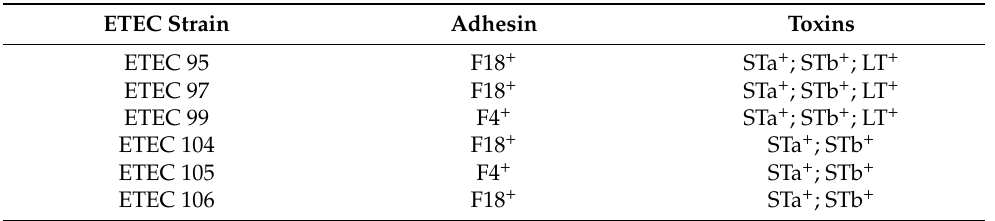
Table 9. Pattern of adhesins and toxins expressed by the six ETEC strains used in this study.